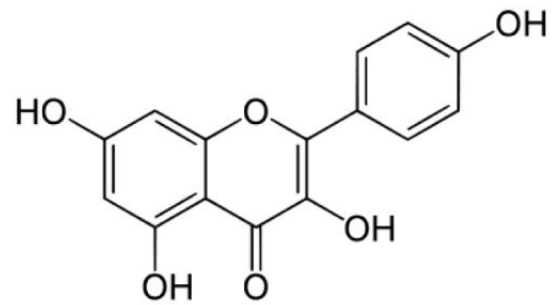
Figure 1. Structure of kaempferol.